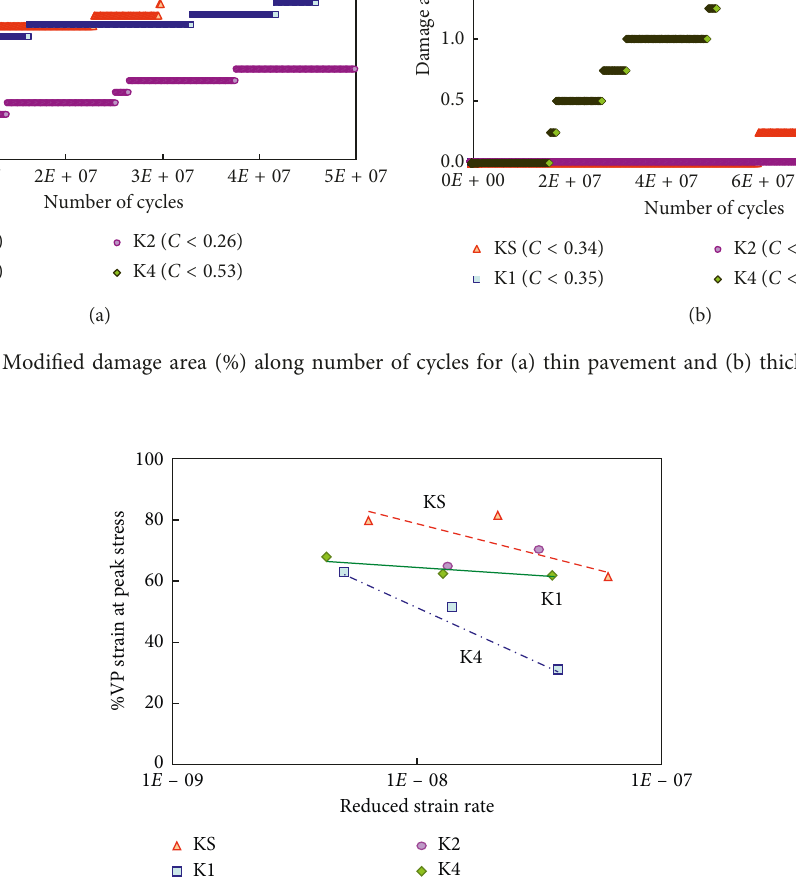
Figure 12: Influence of viscoplasticity on all four mixtures’ behavior.